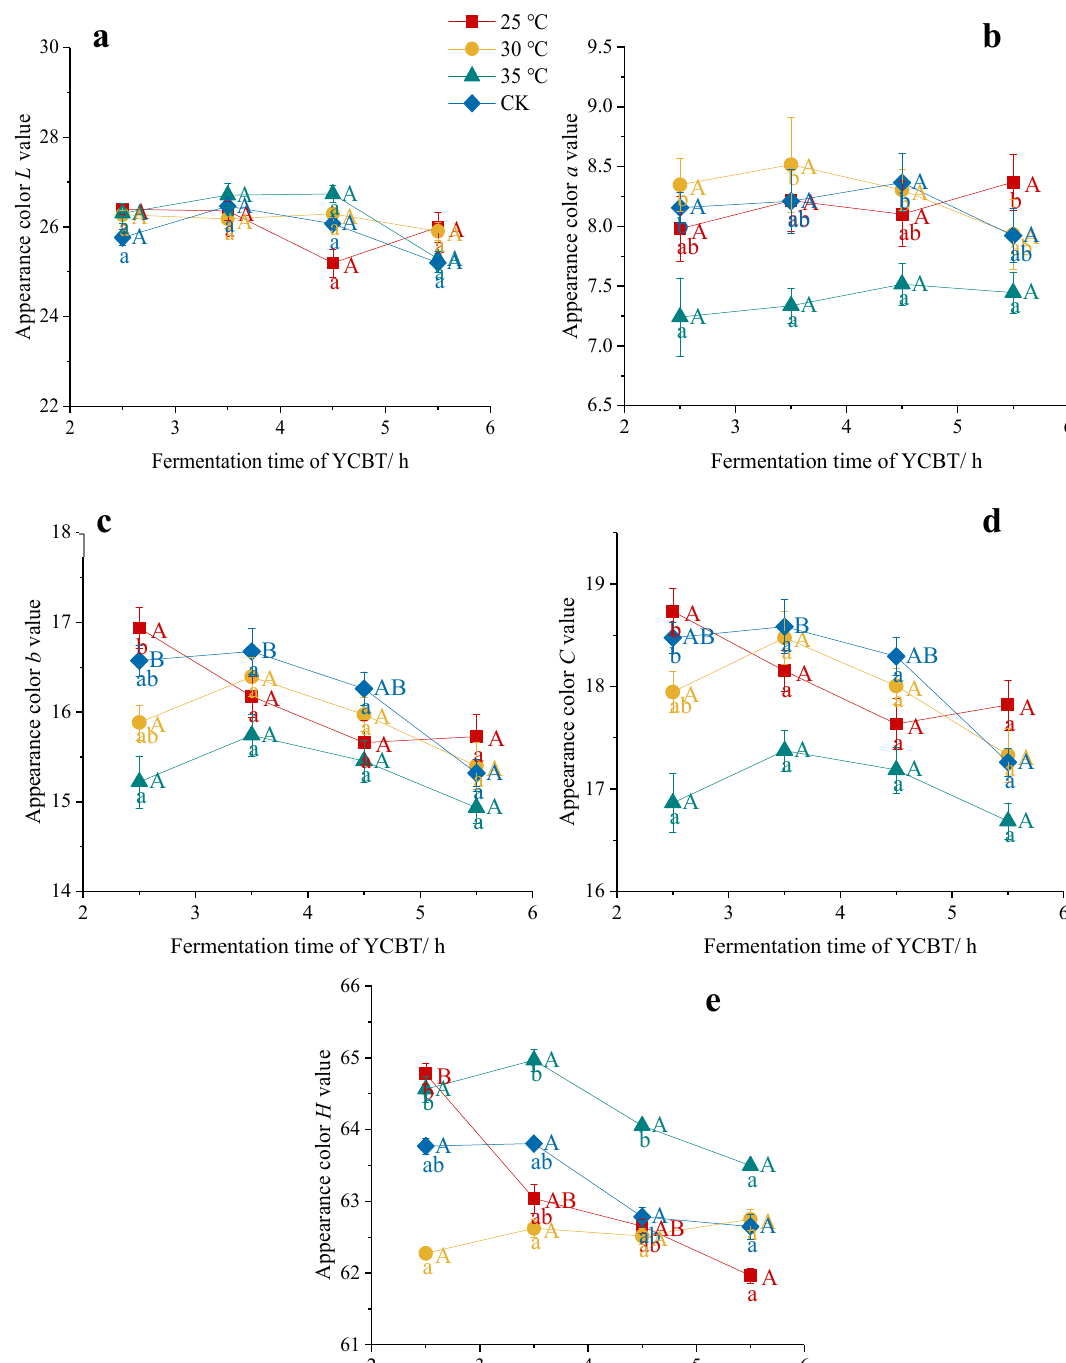
Figure 1. Effects of the fermentation temperature and time on the appearance attributes of Yunnan Congou black tea (YCBT) fermentation: ( a ) L value, ( b ) a value, ( c ) b value, ( d ) C value, and ( e ) H value. Note: Mean values with different lowercase letters indicate significant differences between different fermentation temperatures at the same fermentation time ( p < 0.05); Mean values with different capital letters indicate significant differences between different fermentation times at the same fermentation temperature ( p <